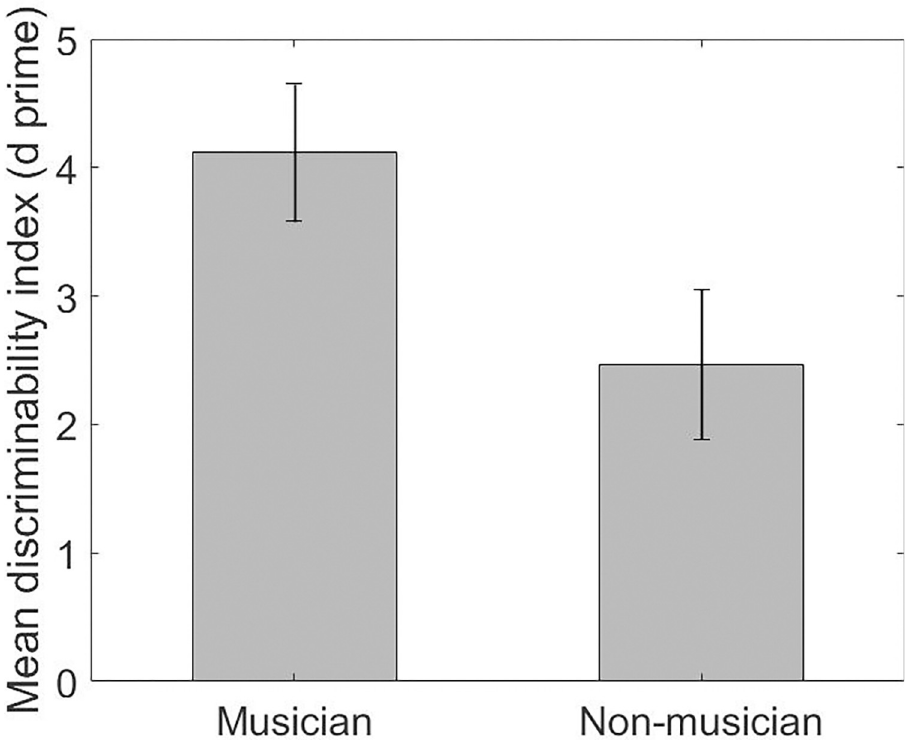
Fig 3. Mean d primes for musicians and non-musicians discriminating between congruent and incongruent trials. Higher scores for musicians reflect higher accuracy. Error bars indicate the 95% confidence intervals. The between group difference is significant at p < .001.